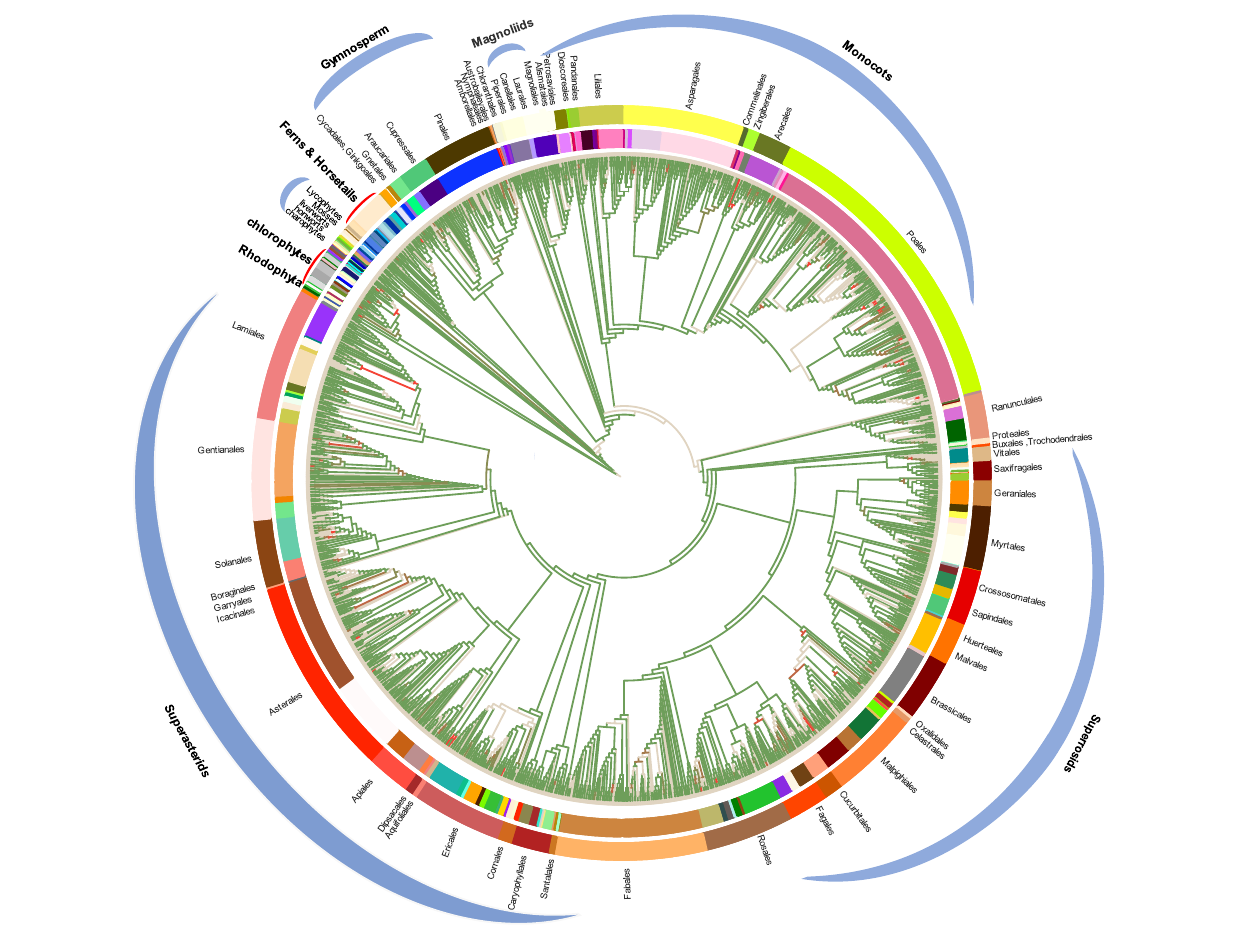
FIGURE 3 | Plastid phylogenomic tree inferred based on the matrix nt12 of 72 protein-coding genes of 3,654 green plants and six Rhodophyta using IQTREE. The colors in the internal circle indicate different families whereas the colors in the external circle indicate different orders (Further details can be found in Supplementary Figure 11 ). The green branches represent the branch with more than 95%